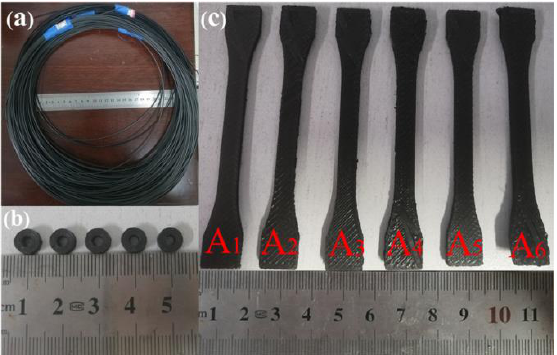
Figure 1. ( a ) SG/GR/PLA/TPU composite wire; ( b ) electromagnetic parameter sample; ( c ) tensile specimens of A 1 ~A 6 composites. Table 3. Composition of SG/GR/PLA/TPU composite